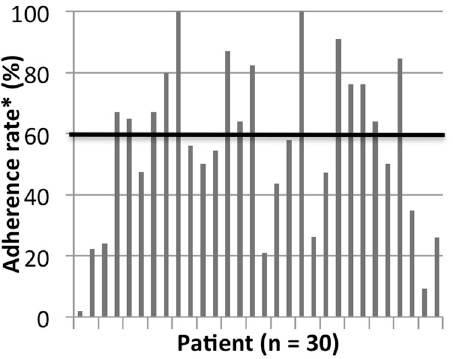
Figure 2. Patients’ adherence to the IDE program. * Moderate adherence: ≥ 60–80%; High Adherence: >80%.